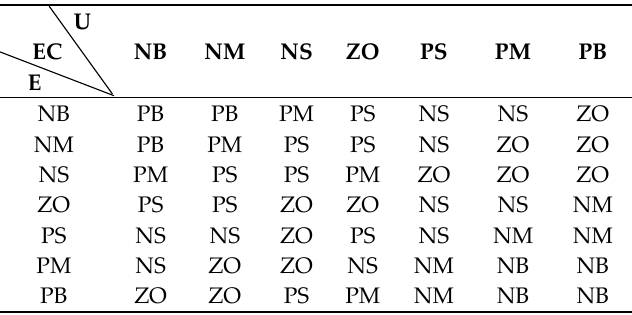
Figure 9 . Membership functions of the input and output variables. Table 6. Changing range of the cleaning performance. Figure 9. Membership functions of the input and output variables. Table 7. Fuzzy control strategy for fan speed. Table 7. Fuzzy control strategy for fan